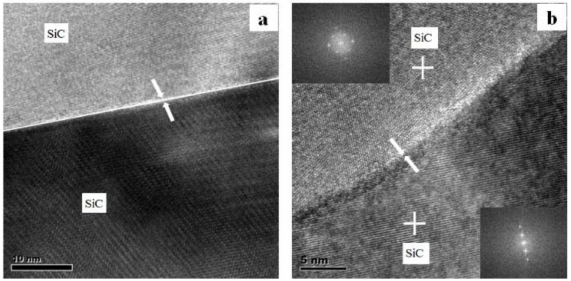
Figure 12. HRTEM image shows the SiC–SiC grain boundary of the SiC ceramic sample with EY9 sintered at 2000 ◦ C with ( a ) amorphous film and ( b ) clean grain boundary.